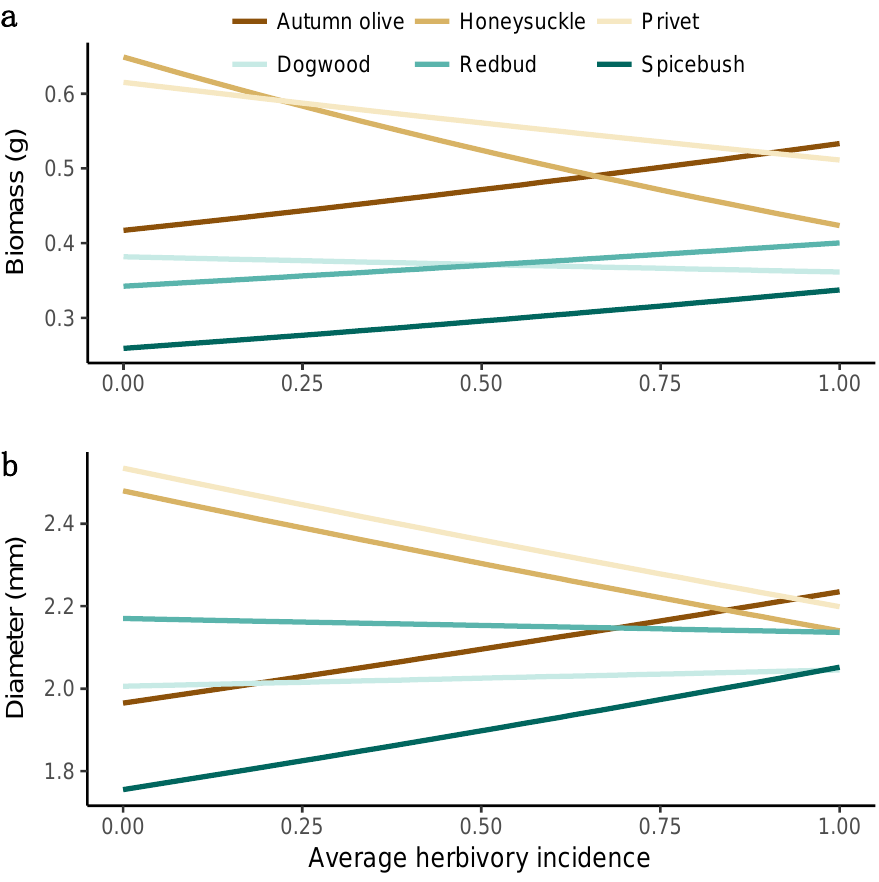
Figure 8. Random-slope-intercept plots for the model estimated marginal between average herbivory incidence and ( a ) biomass or ( b ) diameter of each species. The brown shading indicates the group of invasive species while the blue shading indicates the group of native species.